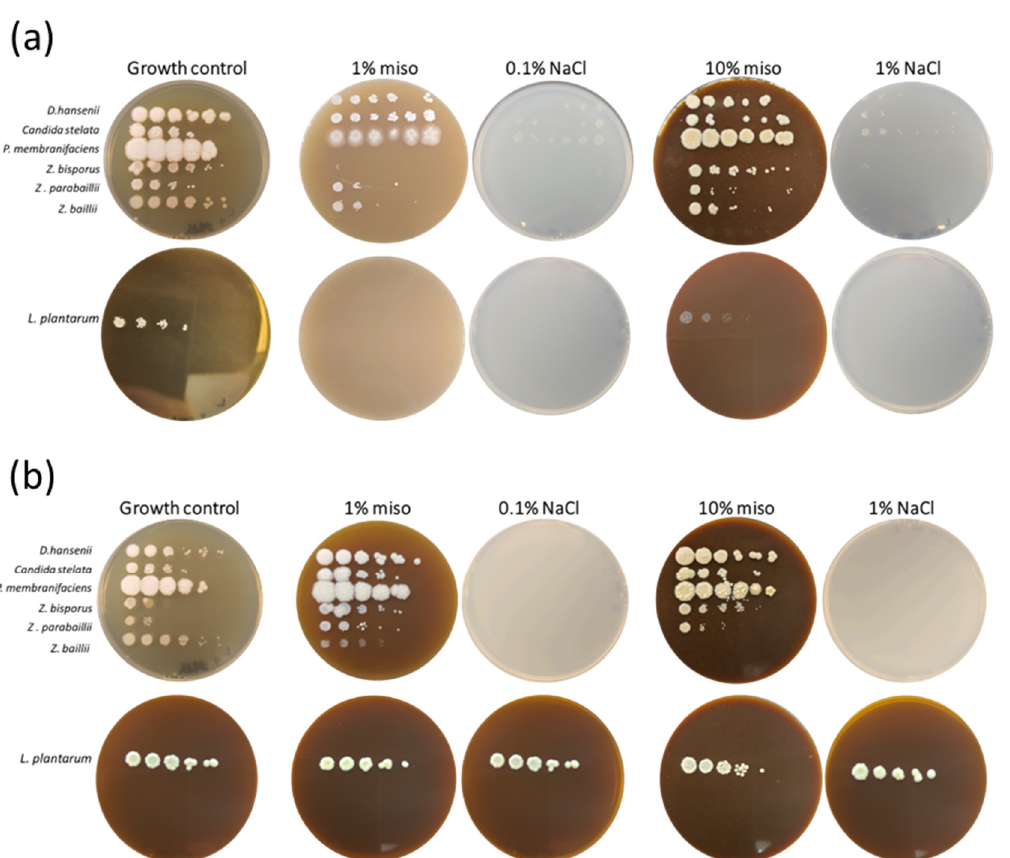
Figure 2. Plates resulting from in vitro antimicrobial activity evaluation tests for food contaminant microorganisms (yeast and Lactiplantibacillus plantarum ) after 14 days of incubation. Positive control plates of YPDF medium for yeast, and of MRS for L. plantarum . From left to right, drops from 10 − 1 to 10 − 5 dilutions. Plates with miso concentrations of 1.0 and 10.0% ( w / w ) or with sodium chloride at equivalent concentrations of each miso plate. ( a ) Results for preliminary test, Test I, with di ff erent miso concentrations or sodium chloride and no nutritive media. ( b ) Results for Test II, with nutritive media and di ff erent miso concentrations or equivalent concentrations of sodium chloride.